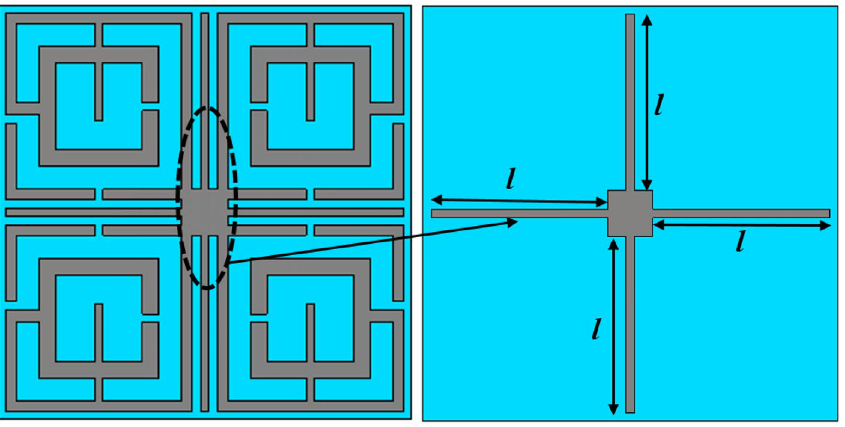
Figure 6. Tuning metal stubs of the proposed MTM unit cell (CST STUDIO SUITE 2019, https:// www. 3ds. com/ produ cts- servi ces/ simul ia/ produ cts/ cst- studio- suite) 42